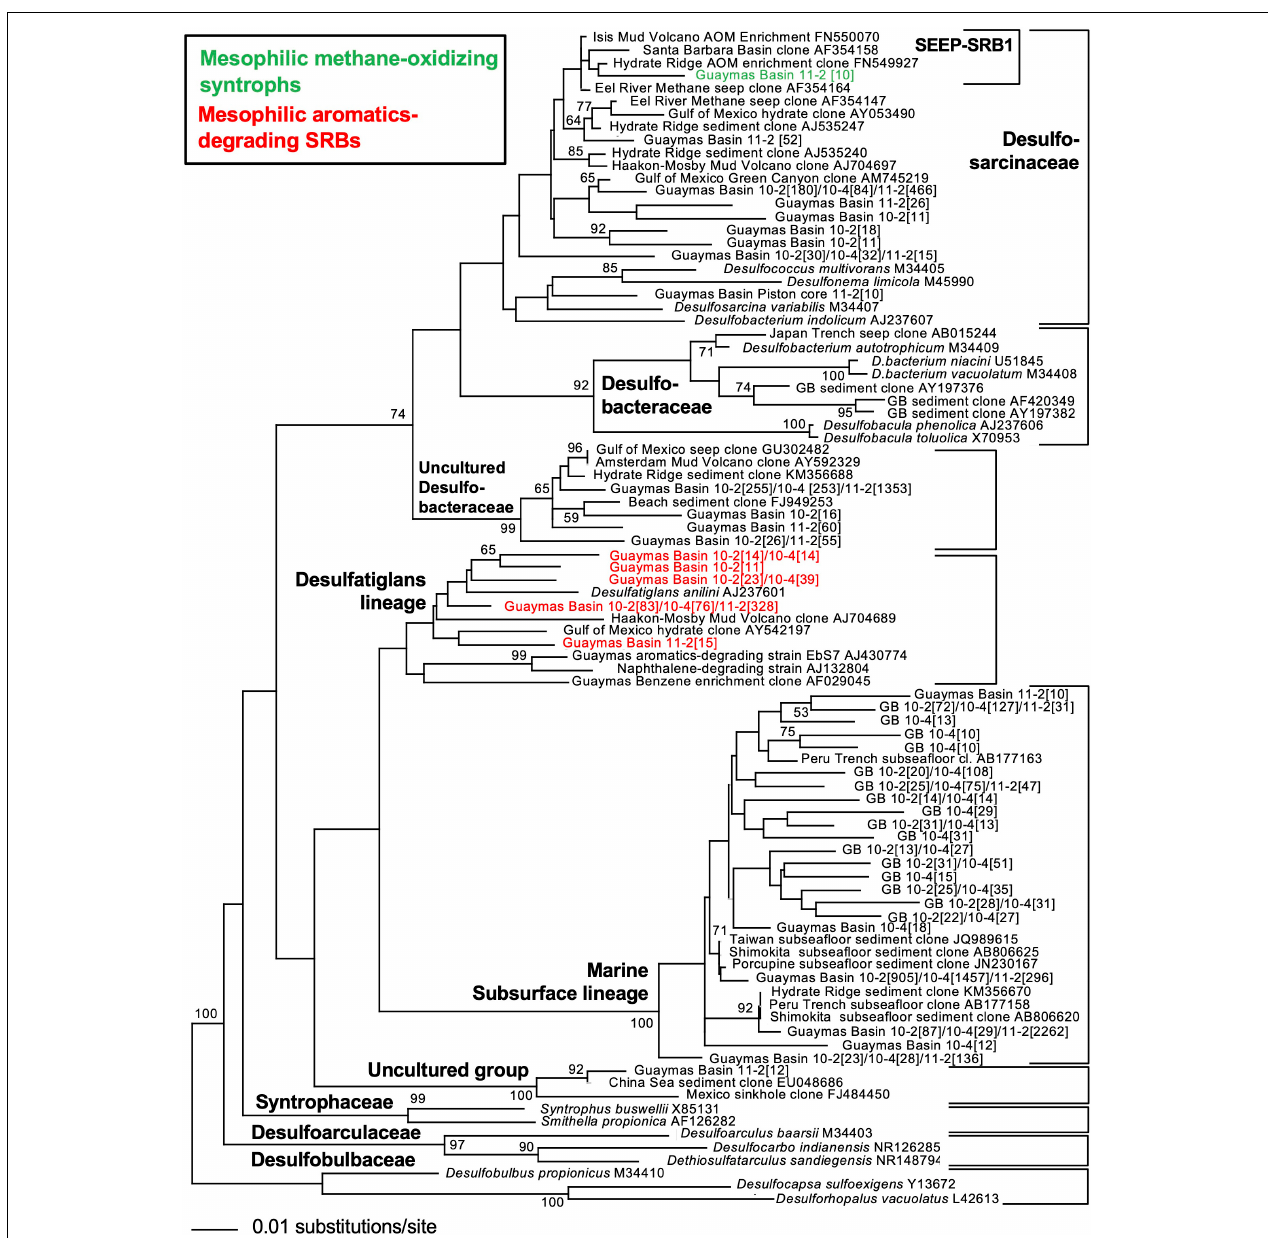
FIGURE 3 | 16S rRNA gene distance phylogeny of frequently occurring deltaproteobacterial ASV sequences according to Escherichia coli nucleotide positions 518–926 using forward primer 518F, and three versions of reverse primer 926R (Teske et al., 2019) in cold shallow subsurface sediments of Guaymas Basin, northwest of the axial valley. The taxon labels refer to number of sequences recovered from piston core 10 and 11 sediment subsections (10-2 = 1.24–1.29 mbsf; 10-4 = 3.73–3.78 mbsf; 11-2 = 1.15–1.20 mbsf). The branching pattern was checked by 1000 NJ Bootstrap iterations. Modified by inferred substrate usage, from Teske et al. (2019)